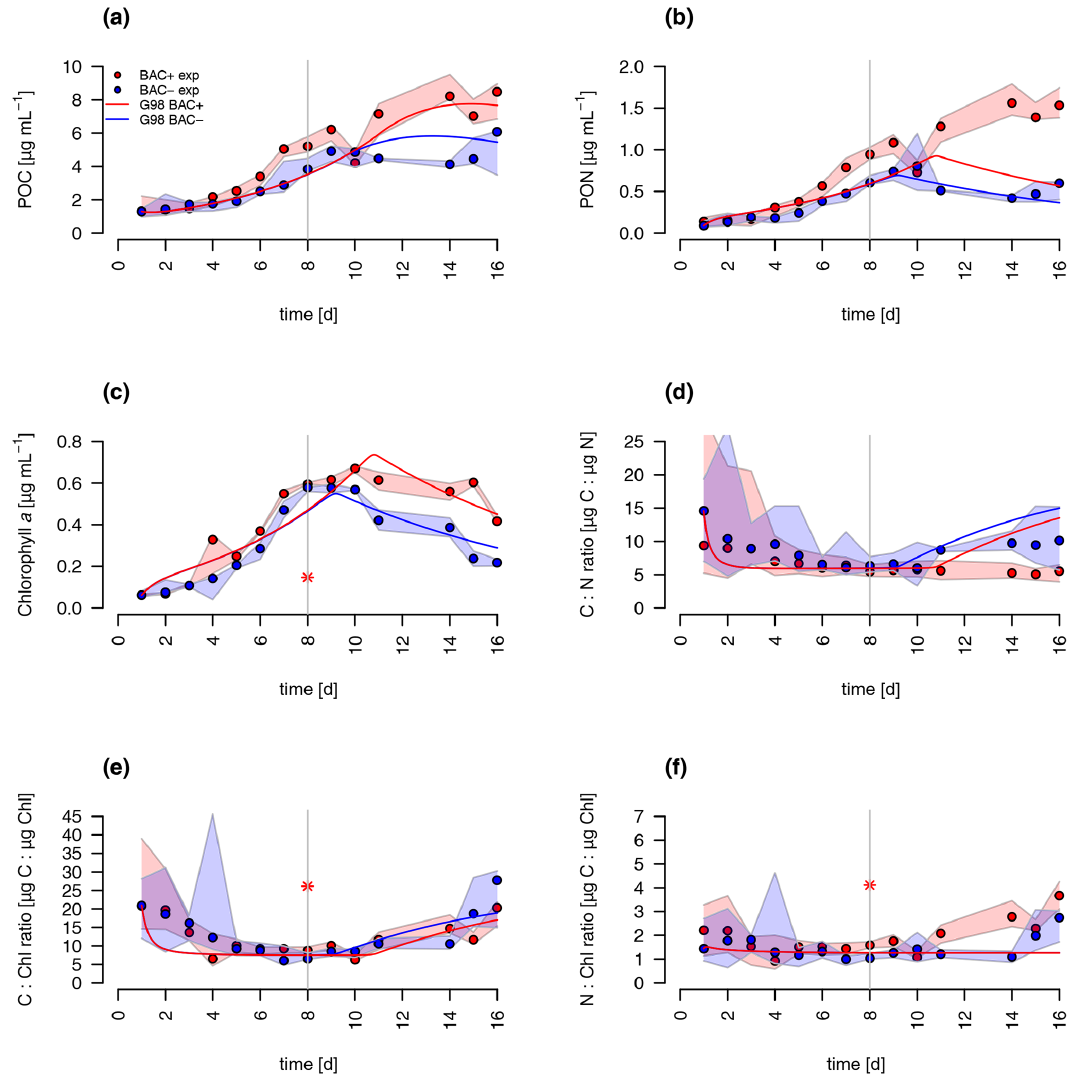
Figure B1. Model fit of the G98 model to the BAC − (blue) and BAC + (red) experiment. Circles show median values, and the colored polygons show the minimum and maximum of the measured data ( n = 2–3, Table S2). Solid lines show the model outputs of (a) POC, (b) PON, (c) Chl (the asterisk indicates a presumed measurement error), (d) C:N, (e) C:Chl, and (f) N:Chl.